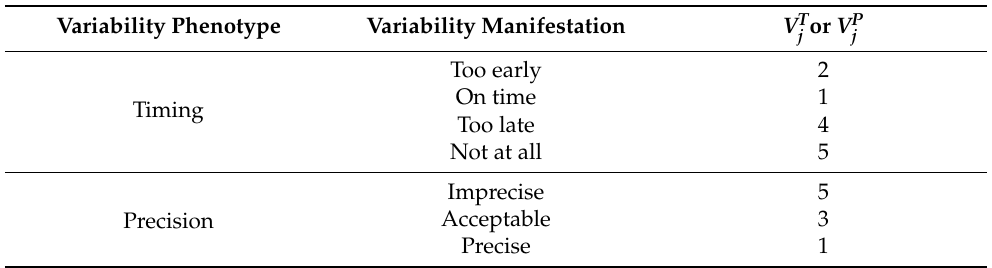
Table A1. Assignment of numerical values to the linguistic description of variability manifestation of the phenotypes timing and